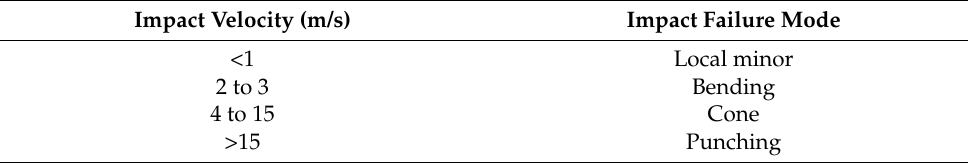
Table 6. The correlations between the impact velocity and the impact failure mode.